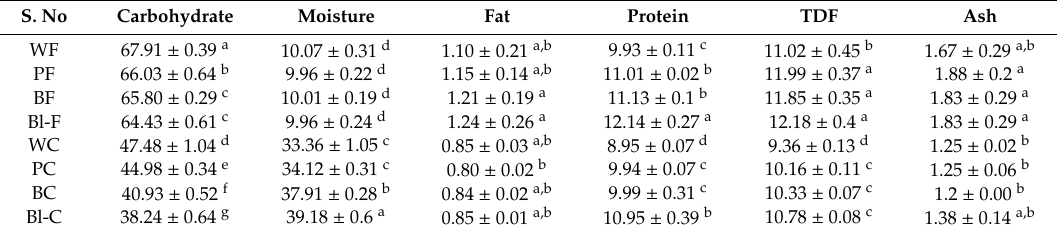
Table 3. Proximate analysis of colored wheat and